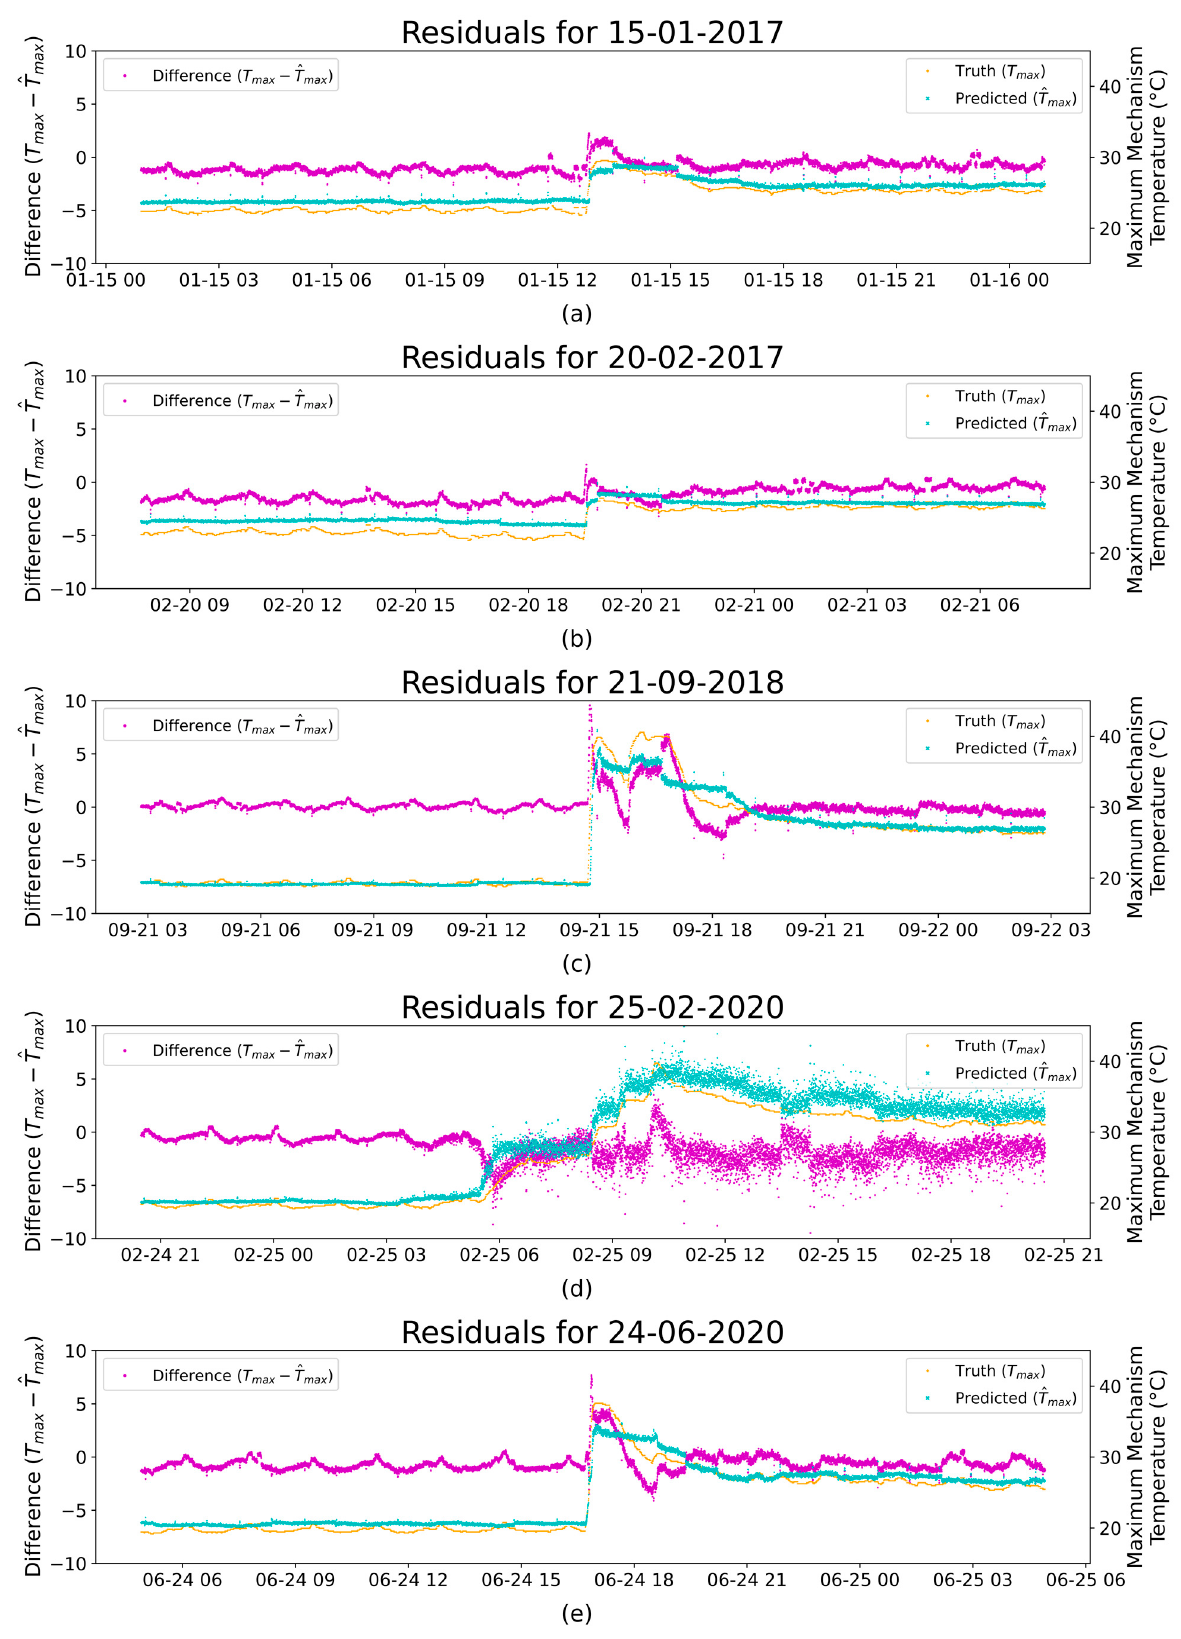
Figure 8. Same as Figure 6 except for the residuals of T ̂ max for the five test cases: ( a ) 2017-01-15, ( b ) 2017-02-20, ( c ) 2018-09-21, ( d ) 2020-02-25, and ( e ) 2020-06-24